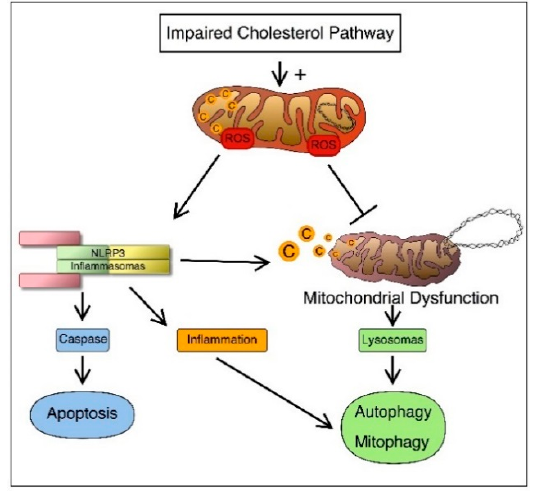
Figure 1. Connection between cholesterol disorders and inflammation. Once the cholesterol pathway is impaired, it can induce activation of the inflammosome and trigger cell apoptosis. On the other hand, production of (reactive oxygen species) ROS causes defective autophagy and/or mitophagy of damaged cells and organelles and this can further lead to NLRP3 (inflammosome) activation.